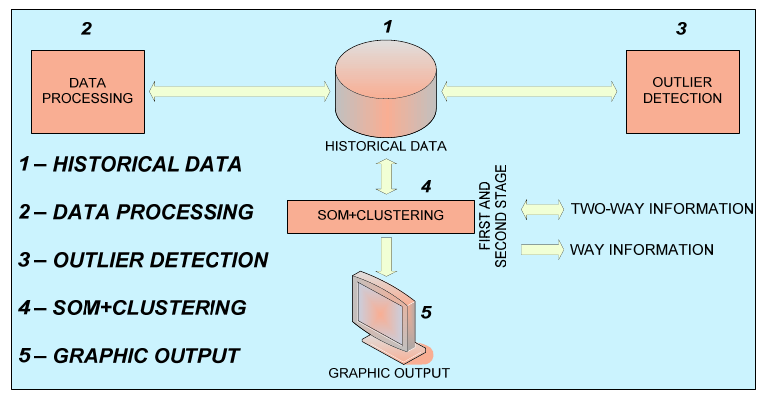
Figure 1. System